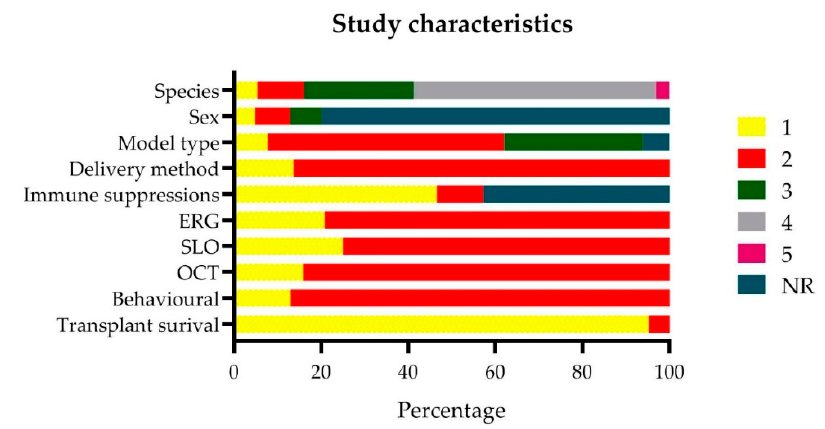
systematic review. Species: 1 pig, 2 mouse, 3 rabbit, 4 rat, 5 other (cat, dog, Macaca mulatta ,